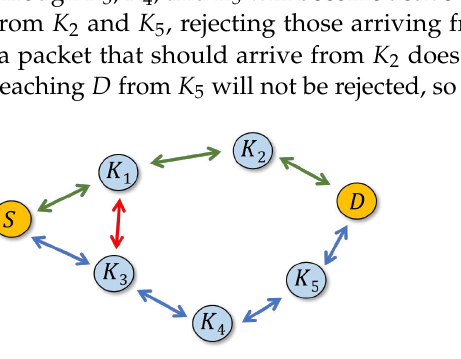
Figure 3. Fuzzy paths provided by the SPD